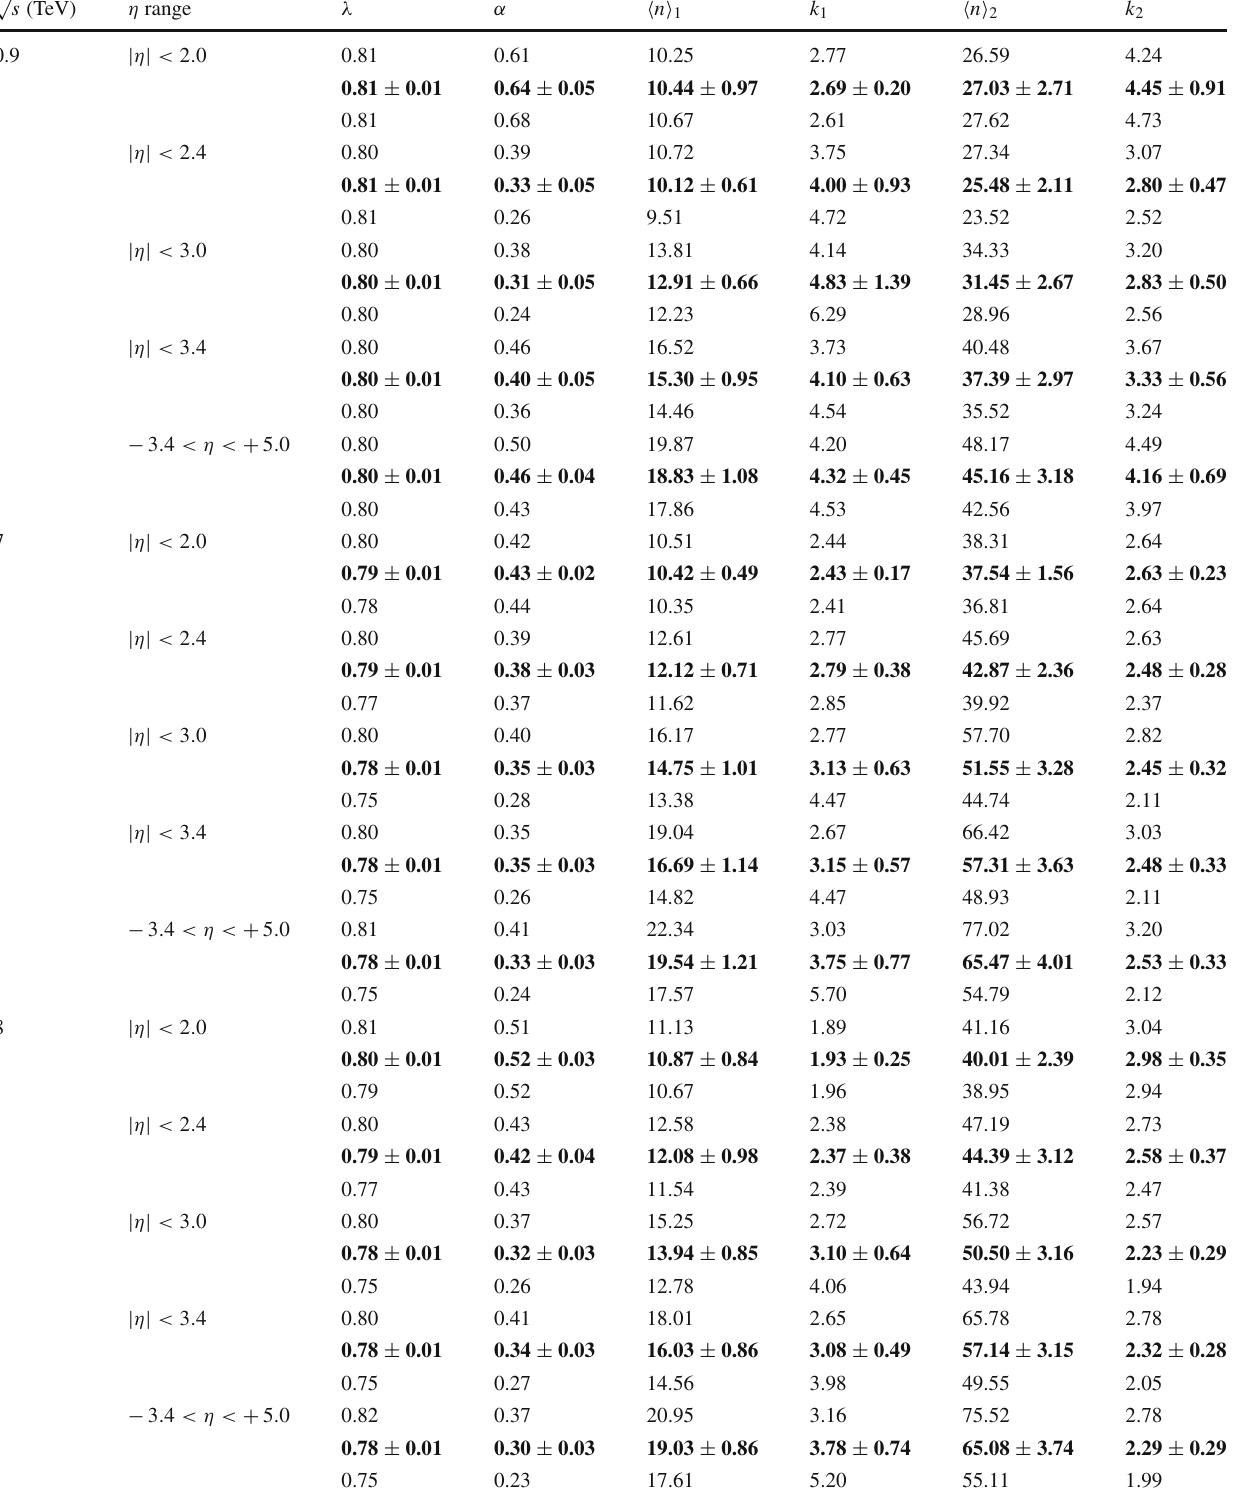
Table 5 Double NBD fit parameters for multiplicity distributions, INEL events. The central values of the parameters are printed in bold with their relative uncertainty, while the top row shows the upper bound fit parameters, and the bottom row the lower bound ones √ s (TeV) η range λ